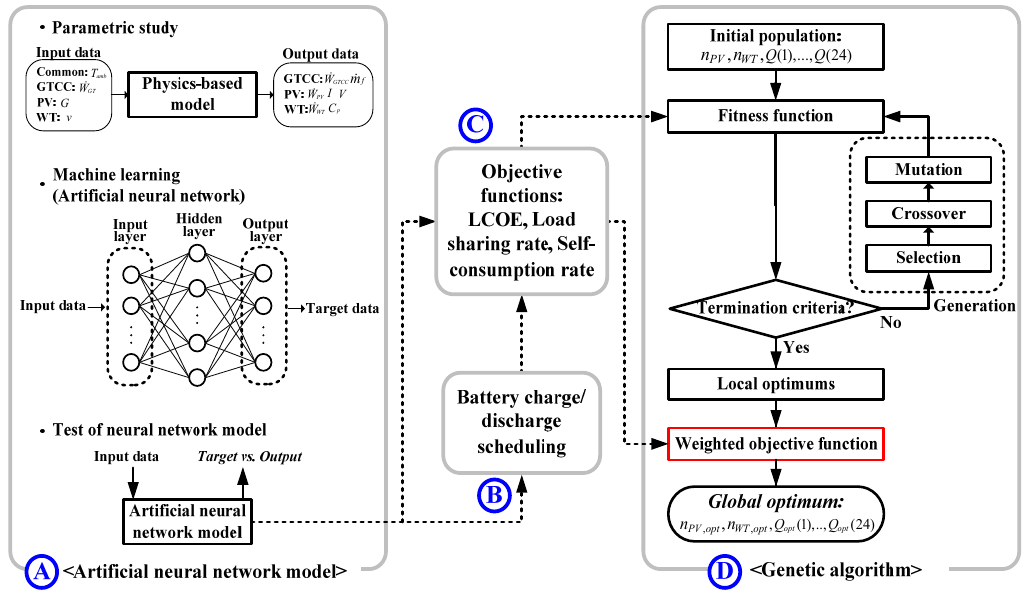
Figure 10. Processes for optimization of the size and operation strategy of the distributed generation system.